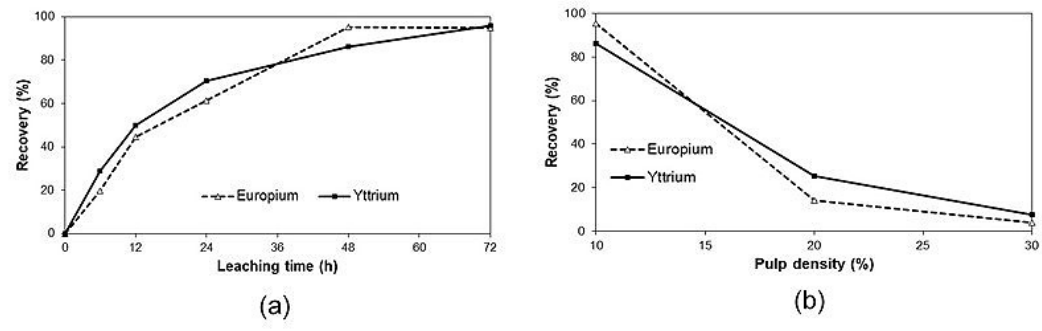
Figure 2. ( a ) Recovery of europium and yttrium with HNO 3 at 250 g/L and 10% of solids; ( b ) Recovery of europium and yttrium at different percentages of solids with HNO 3 at 250 g/L for 48 h of agitation. To complement the study of the leaching process, the influence of pulp density was assessed. In Figure 2b, the europium and yttrium recoveries are shown for leaching tests with different percentages of solids at 250 g/L of HNO 3 for 48 h of stirring. In the case of europium, the recovery decreases from 95% to values of 14% and 4% for a pulp density of 20% and 30%, respectively. On the other hand, yttrium recoveries decrease from 86% to 25% and 8% for pulp densities of 20% and 30%,